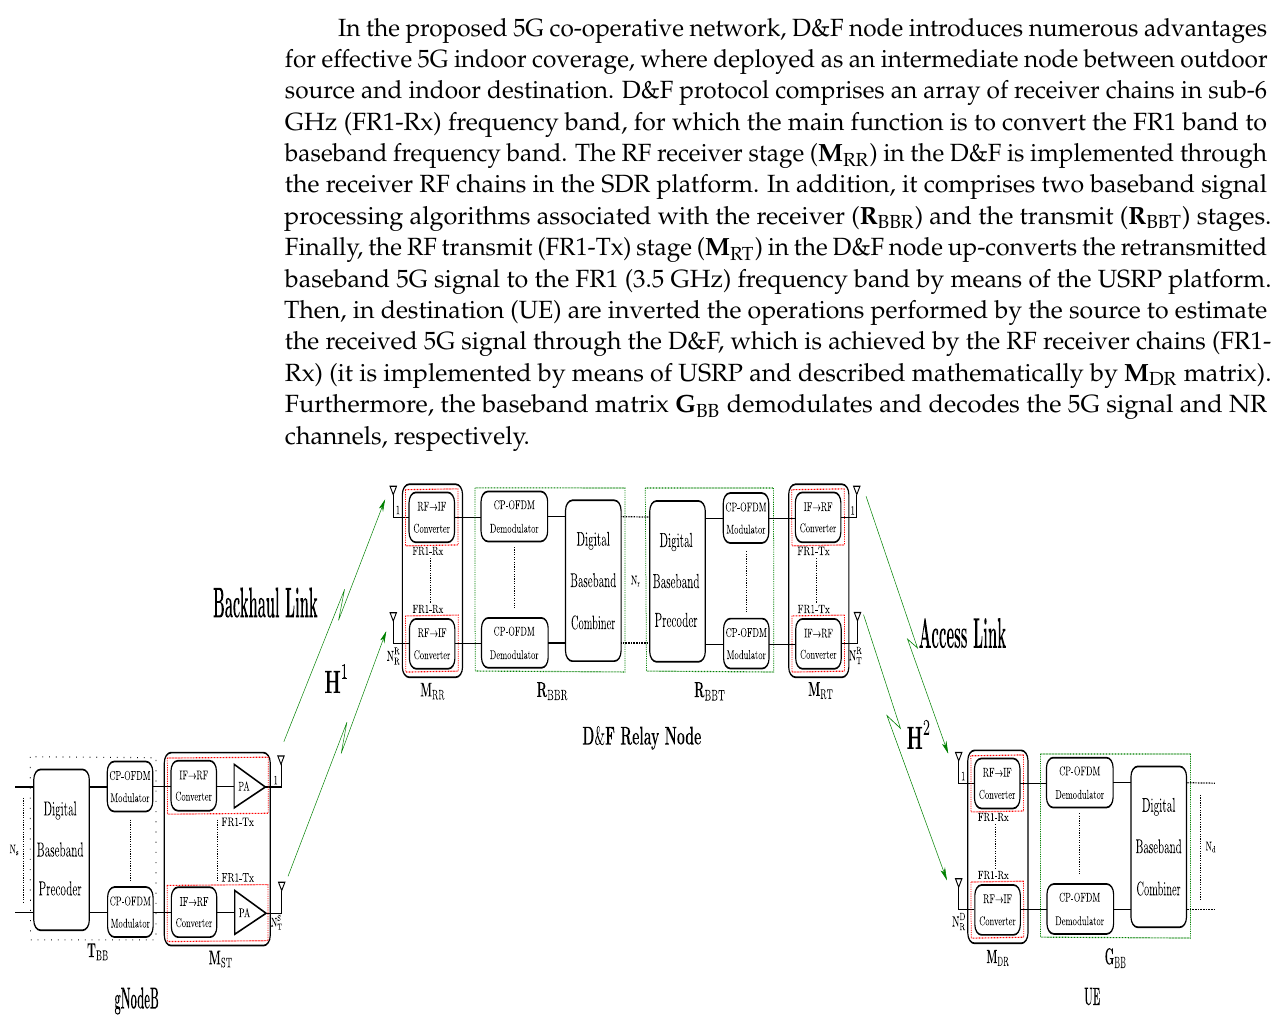
Figure 1. system model for 5G DL transmission via D&F co-operative